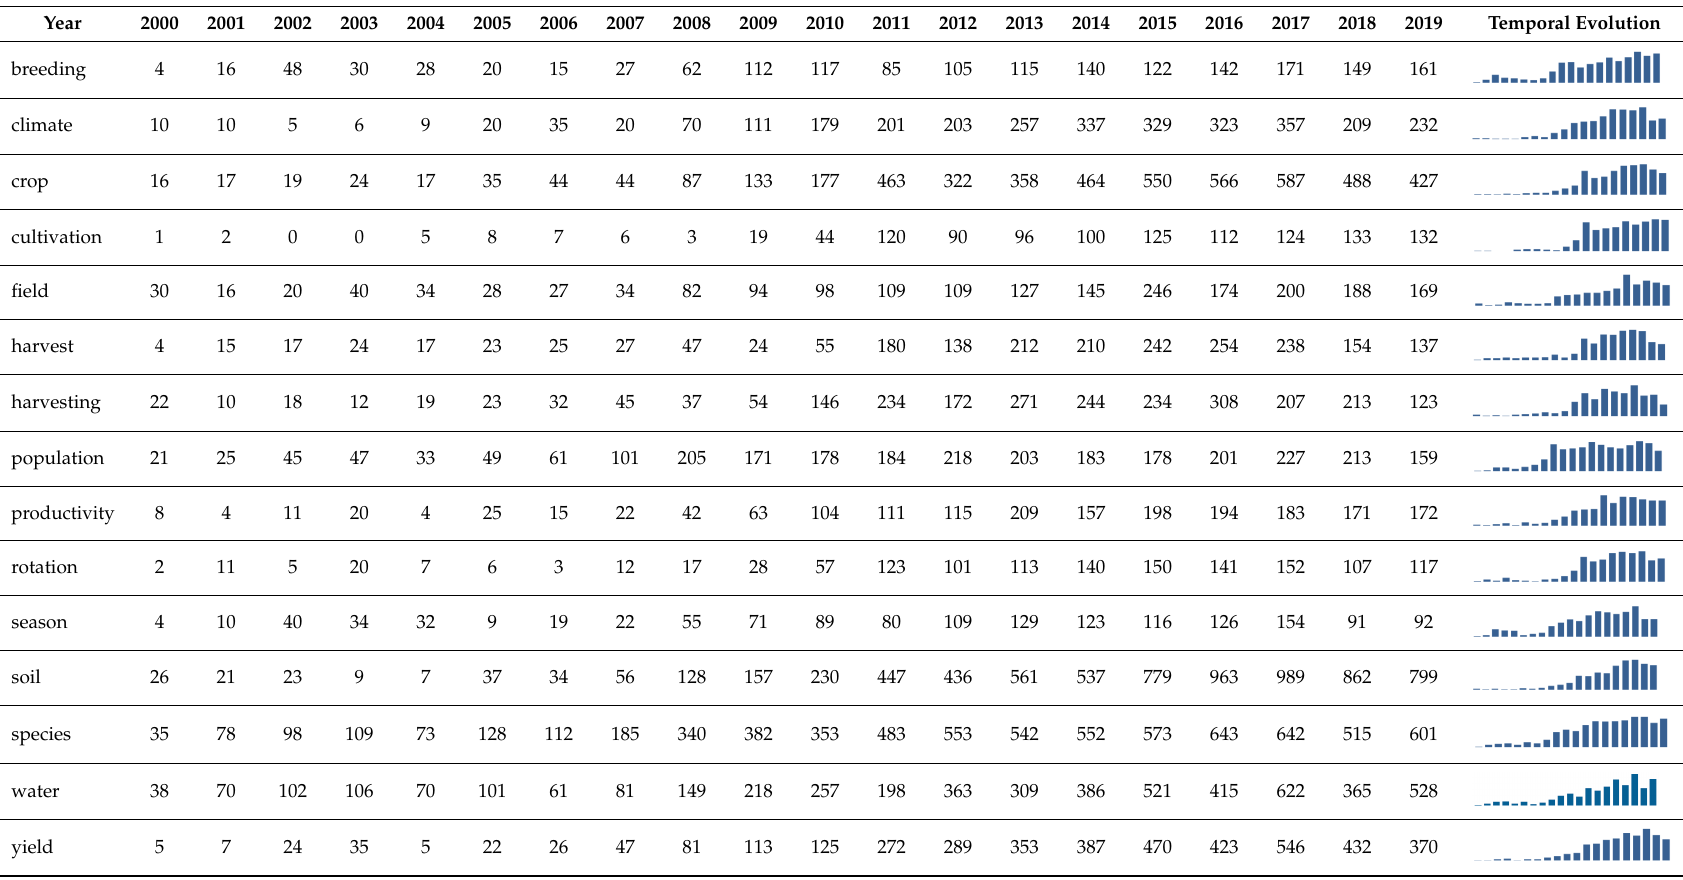
To classify the terms in the two considered decades, the weighted average of the values over several years was made. For each year, the ratio between the occurrences of a term and the total number of articles in the Bioenergy field was created. The overall score of a term (Equation (1)) was obtained by the weighted mean of the values over the years, giving higher weight to the most recent years to better focus the attention on the current situation: